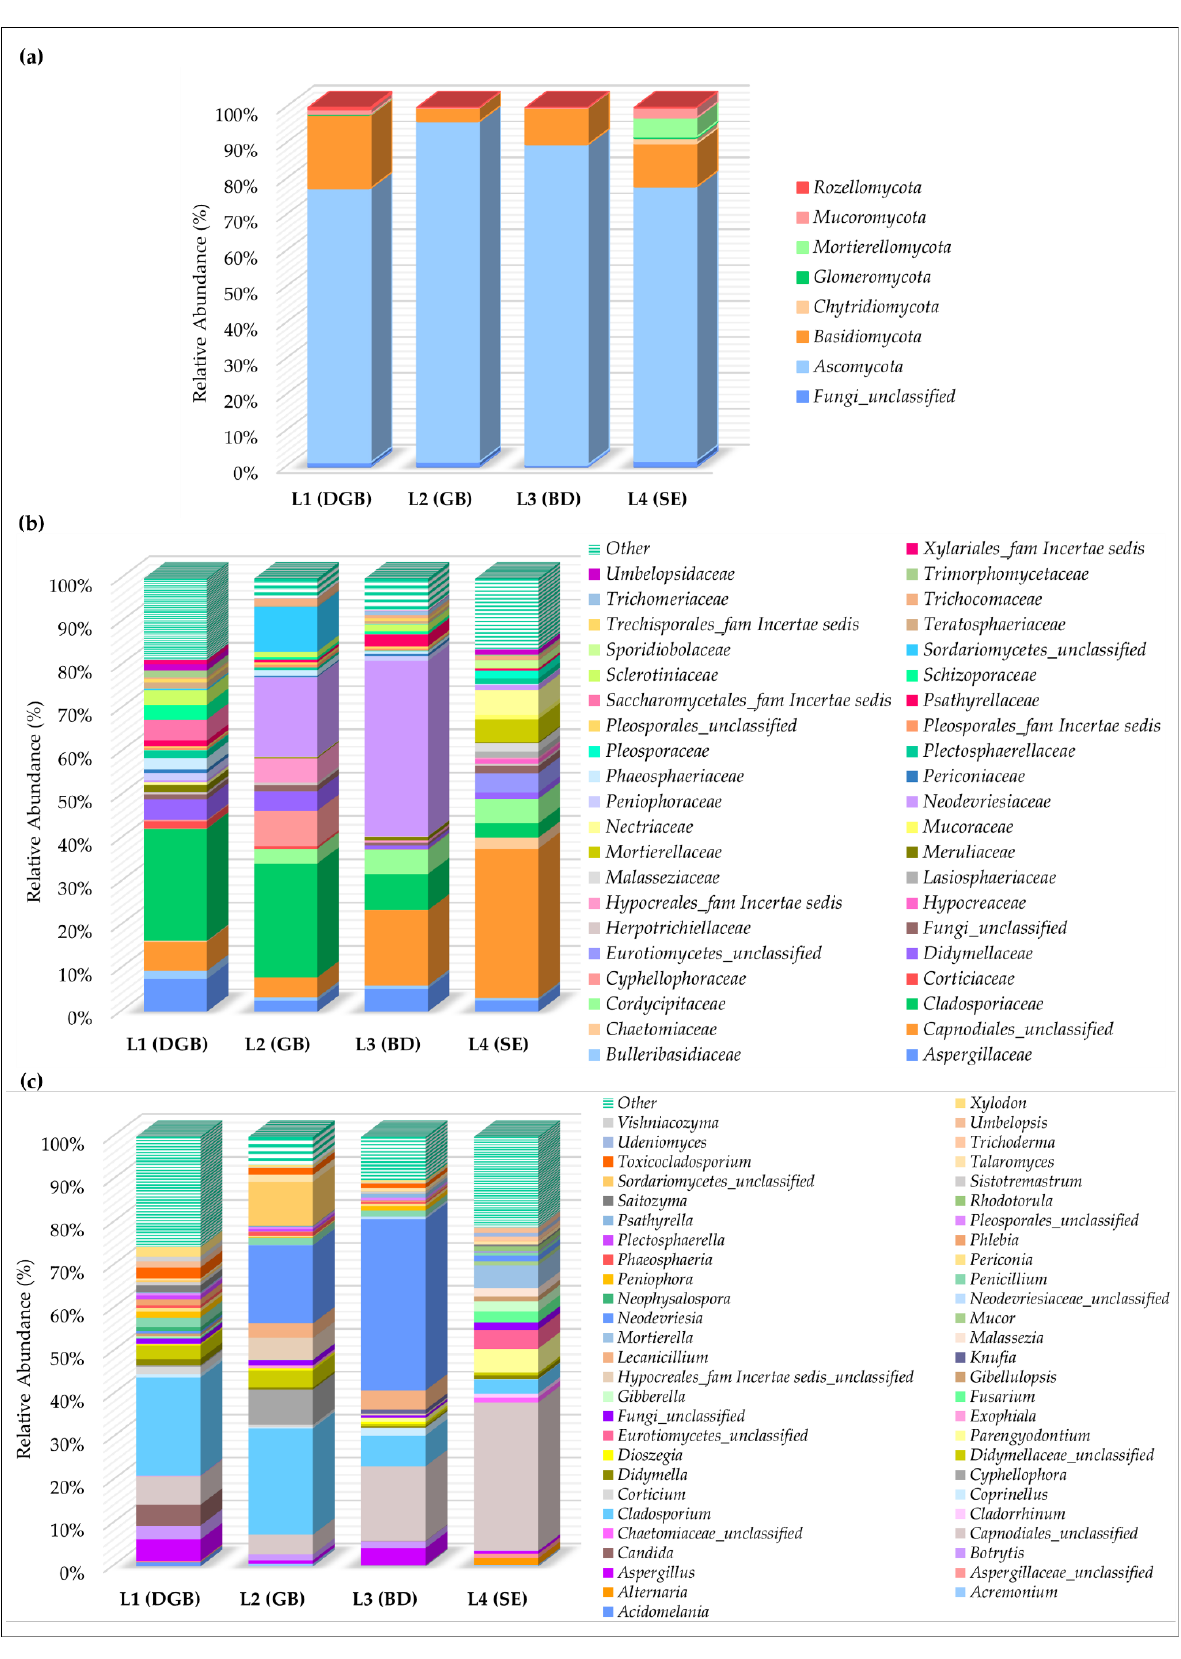
Figure 4. Relative abundance of the metabarcoding fungal diversity at ( a ) phylum, ( b ) family and ( c ) genus level per